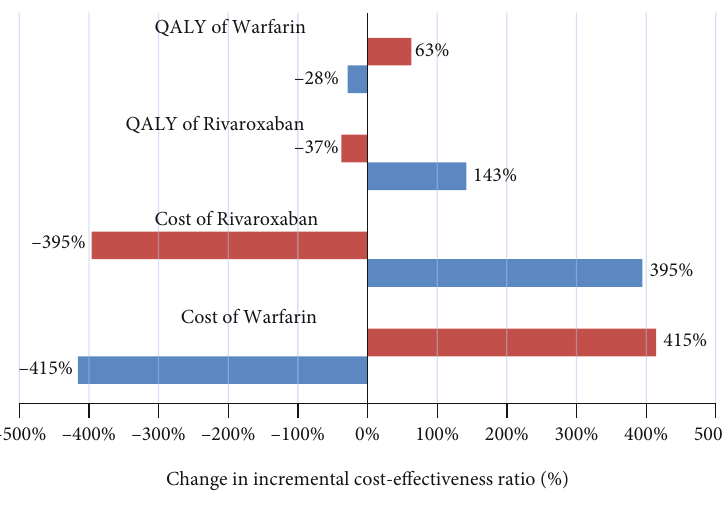
Figure 3: Tornado diagram of cost-utility for patients with AF under treatment with rivaroxaban and